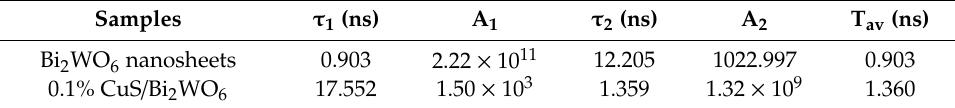
Table 2. Parameter of time-resolved PL decay curves.